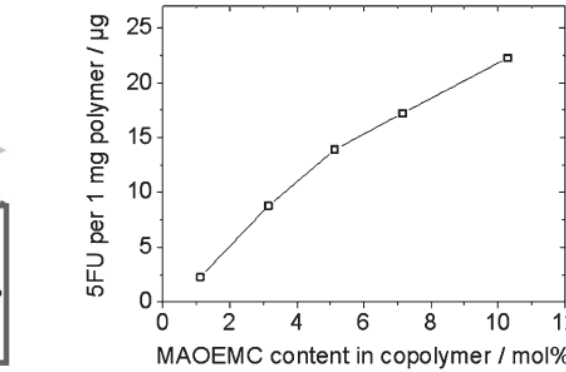
Figure 6. 5-fluorouracil released under 266 nm irradiation from drug-7-(2’- methacryloyloxyethoxy)-4-methyl-coumarin conjugated to PMMA. Reproduced from reference [45] with permission of